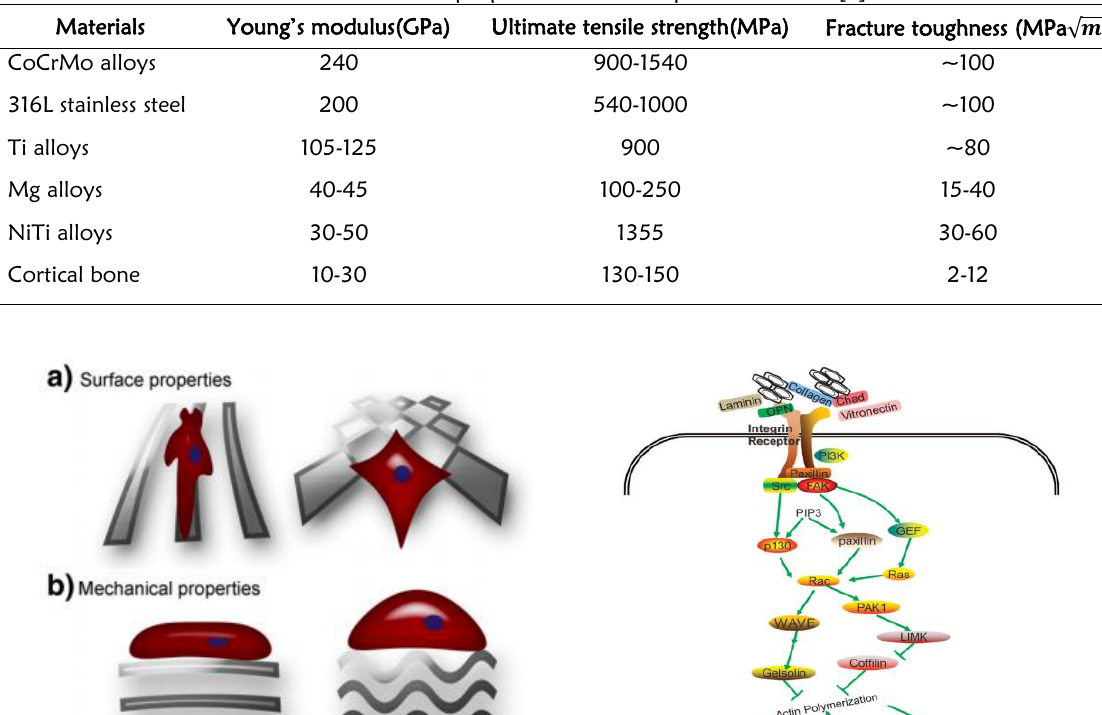
Table 1: Mechanical properties of metal implants and bone [9]